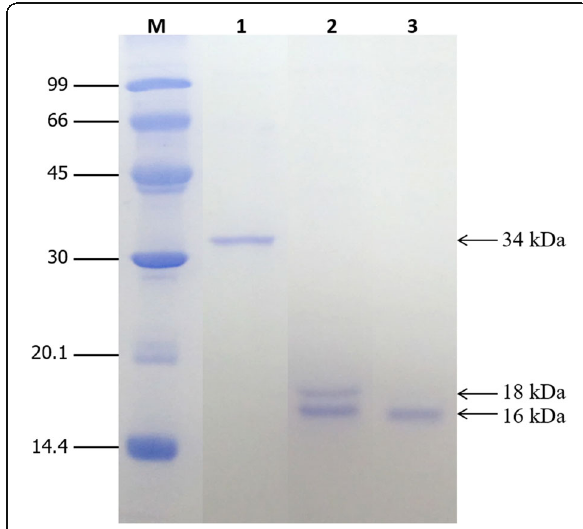
Fig. 4 SDS-PAGE analysis of the purified rSol g 4.1 protein and product after cleavage of the N-terminal tag: lane M – molecular weight standards; lane 1 – purified rSol g 4.1 protein; lane 2 – cleavage of the tagged protein by one unit of enzyme for 7 h; and lane 3 – Sol g 4.1 protein after tag deletion and